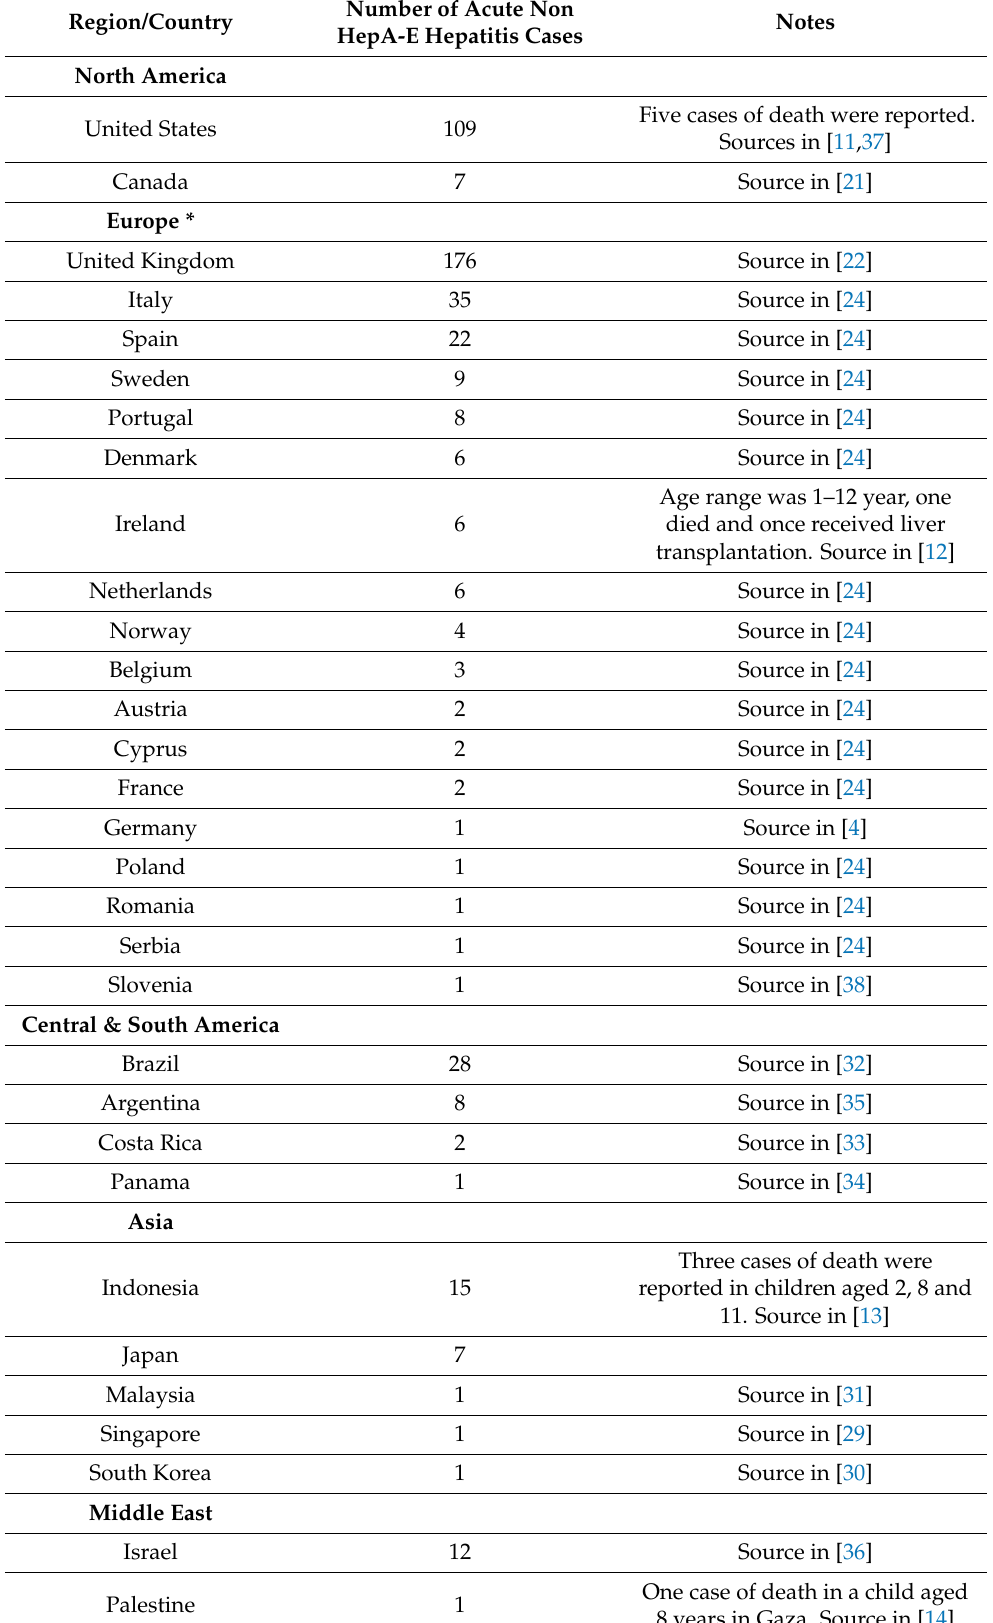
Table 2. Detailed description of the acute non HepA-E hepatitis cases per country as of 13 May 2022.